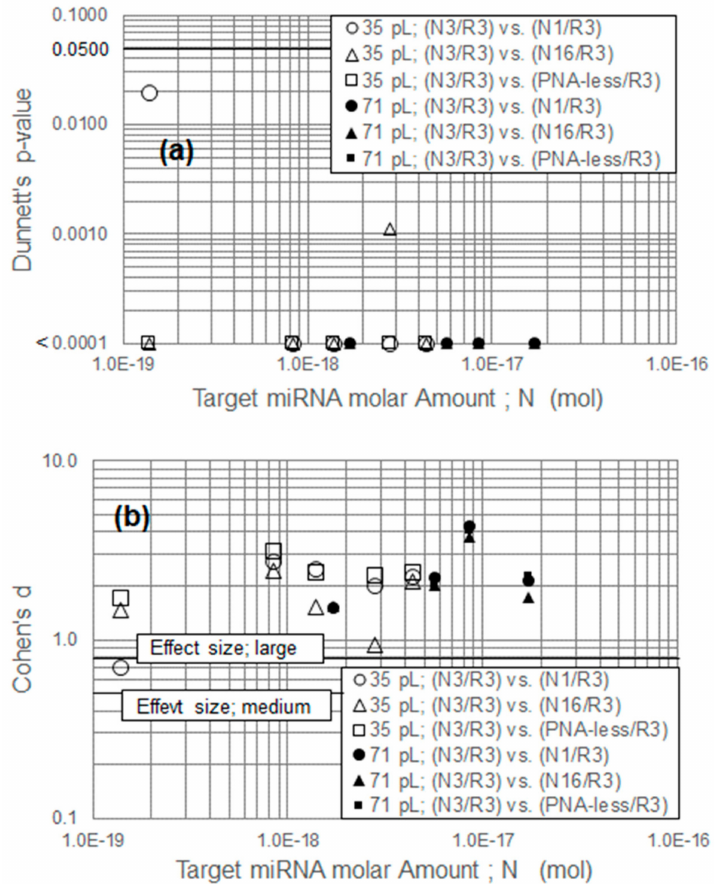
Figure 8. ( a ) Dunnett’s p -value and ( b ) Cohen’s d -value shown between the complementary and noncomplementary systems as (N3 / R3) versus (N1 / R3) and (N3 / R3) versus (N16 / R3).